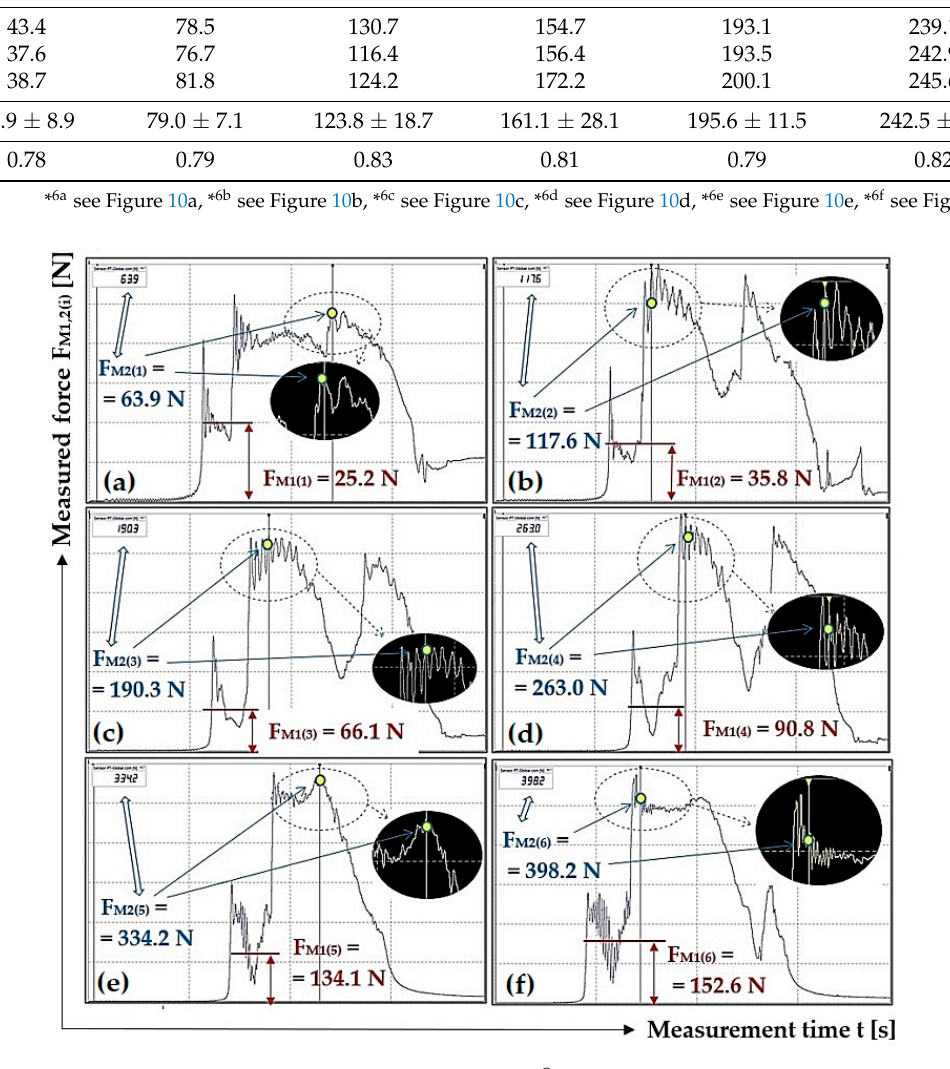
Figure 10. Tensile forces measured using DeweSoft ® software for different load weights at the scraper plough angle of inclination β = 50